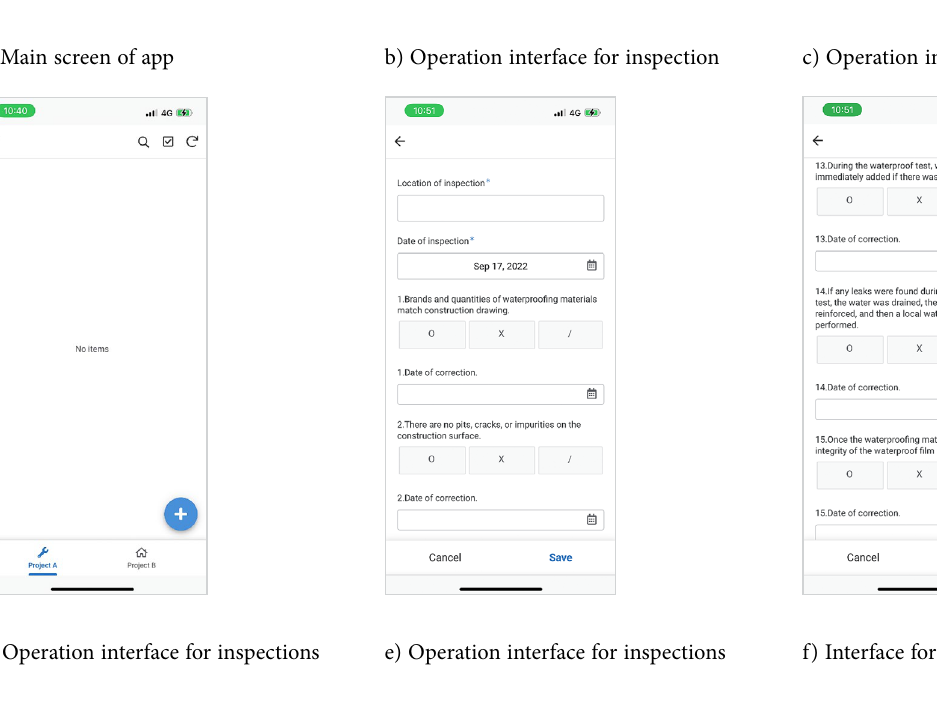
Figure 24. User permission settingsFigure 23. Screen image of developed app